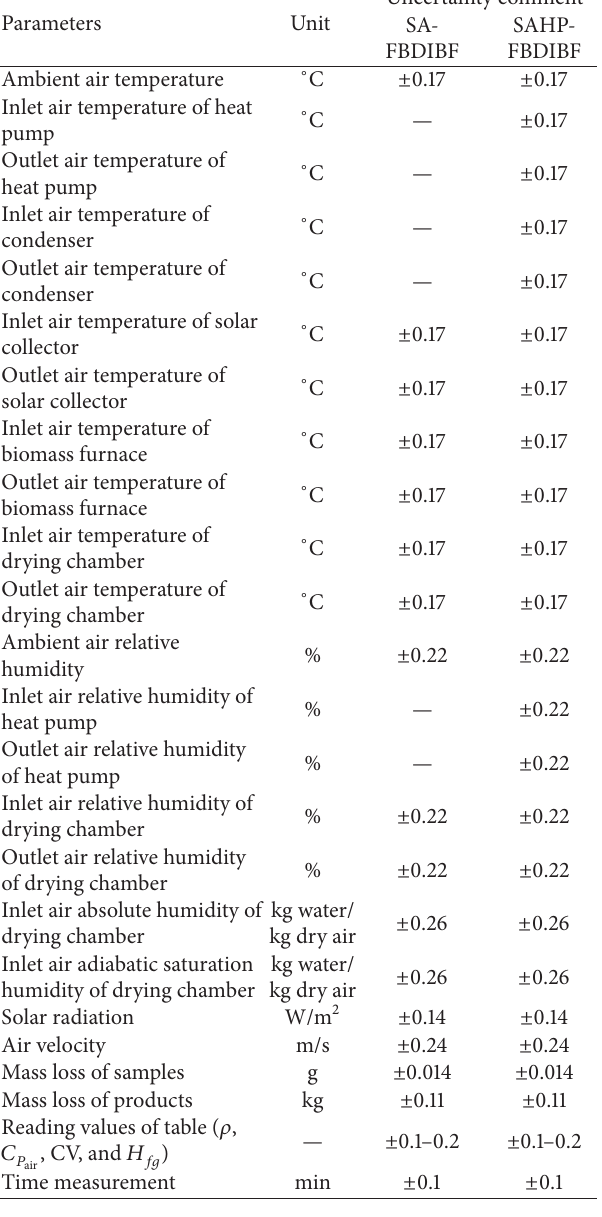
Table 2: Uncertainties of the parameters during drying experiment of paddy.